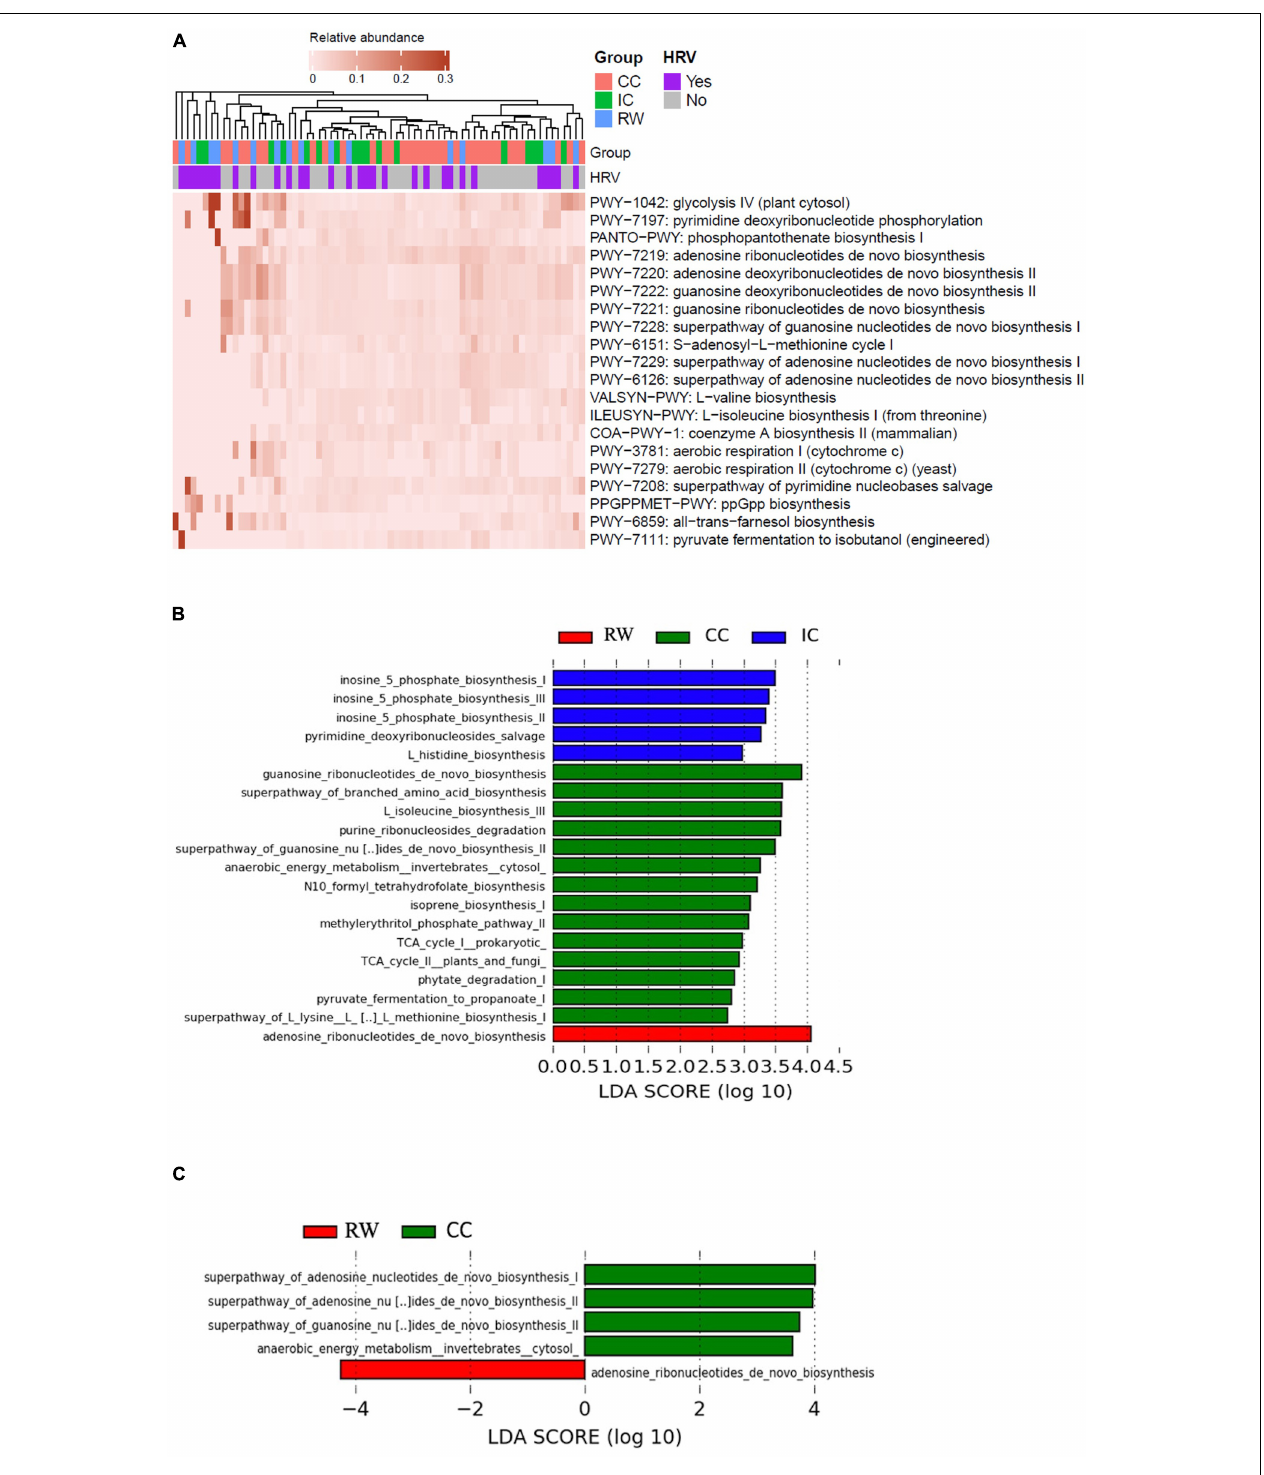
FIGURE 4 | Functional characterization of NP microbiome in control and RW subjects. (A) Heatmap of the top 20 most abundant MetaCyc pathways in individual samples as characterized by HUMAnN2. Samples were hierarchically clustered based on Bray–Curtis dissimilarity of pathway abundances, and color coded according to group or HRV status as indicated. (B) Histogram of discriminative pathways across all samples as identified by LEfSe. Kruskal–Wallis test was performed with clinical features as the only grouping factor at the thresholds of LDA score > 2 and P < 0.05. (C) Histogram of discriminative pathways across all samples as identified by LEfSe in which clinical features and HRV status were analyzed as “class” and “subclass” factors respectively. RW, recurrent wheeze (red); IC, inpatient controls (blue); and CC, community controls (green).